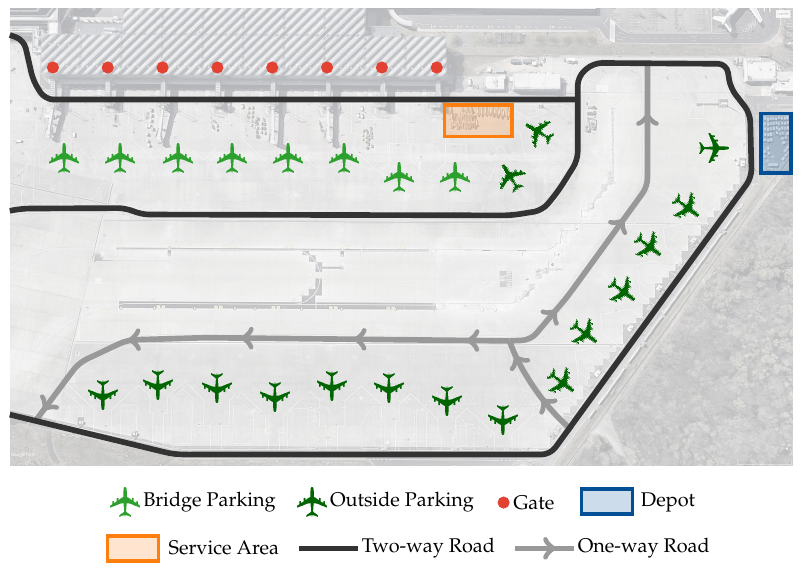
Figure 2. Selected part of the apron at Cologne Bonn Airport Source: Cologne Bonn Airport [online], 50 ◦ 52 (cid:48) 56 (cid:48)(cid:48) N 7 ◦ 07 (cid:48) 10 (cid:48)(cid:48) E, Height 574m, Google Earth © GeoBasis-DE/BKG 2009, URL: http://www. google.com/earth on 29 June